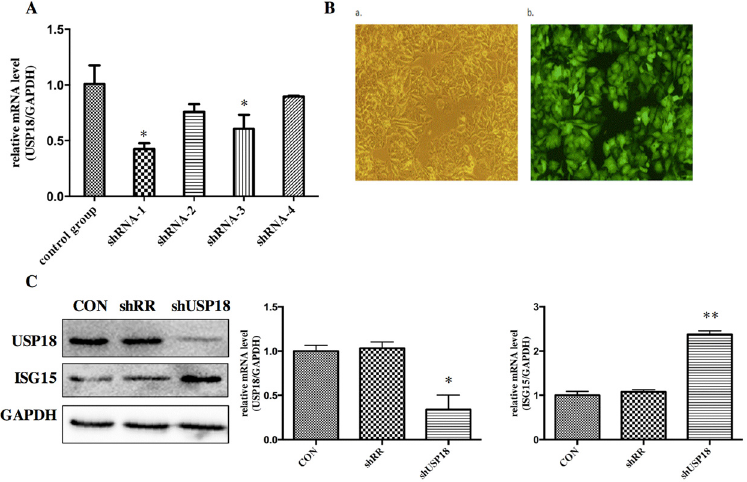
Fig 2. USP18 expression is efficiently suppressed in lentiviral-vectors-transduced HepG2.2.15 cells. (A) Analysis of USP18 mRNA levels. Hepg2.2.15 cells were treated with ShUSP18-1, -2, -3, -4 and shRR. Quantitative real-time PCR analysis was performed to analyze the level of USP18 mRNA 72 hours after transduction. (B) Fluorescence images of Hepg2.2.15 cells transfected for 72 hours in six-well plates with shUSP18 – 1 per well (MOI = 10). GFP expression was observed under light (a) and fluorescence (b) microscopy (×100). (C) Protein was collected after transduction of shUSP18-1 and levels of USP18 and ISG15 protein in each group were determined by western blot. Lane 1: shUSP18 – 1 lentivirus group. Lane 2: shRR lentivirus group. Lane 3: normal control group. The results are presented as the means ± SD, n = 3, error bars indicate SD. * P < 0.05; ** P < 0.01 vs.